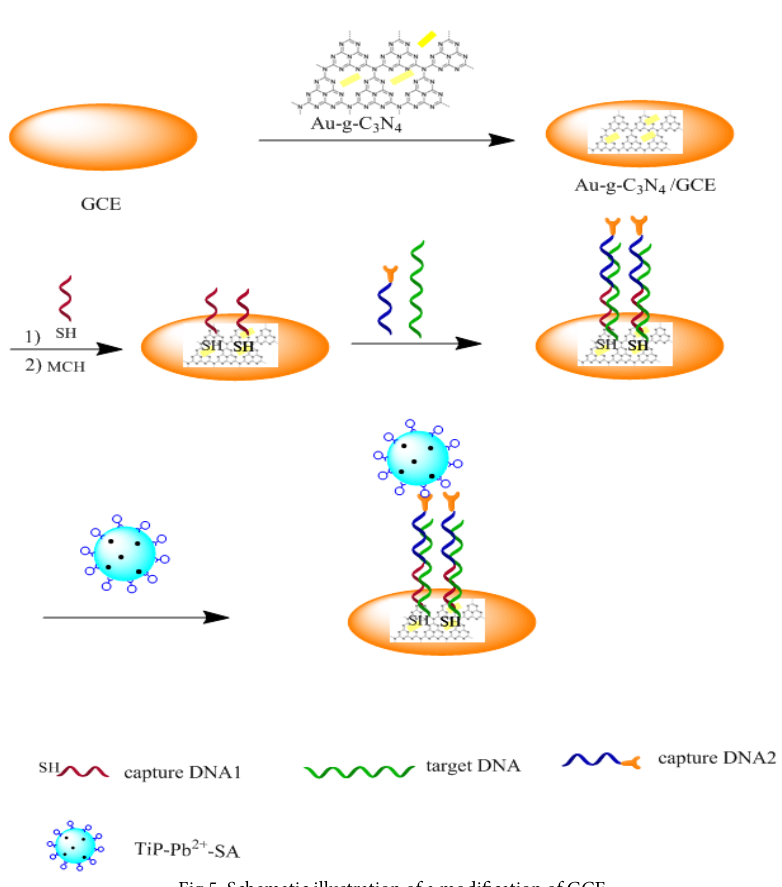
Fig.5. Schematic illustration of a modification of Fig.5- Schematic illustration of a modification of GCE